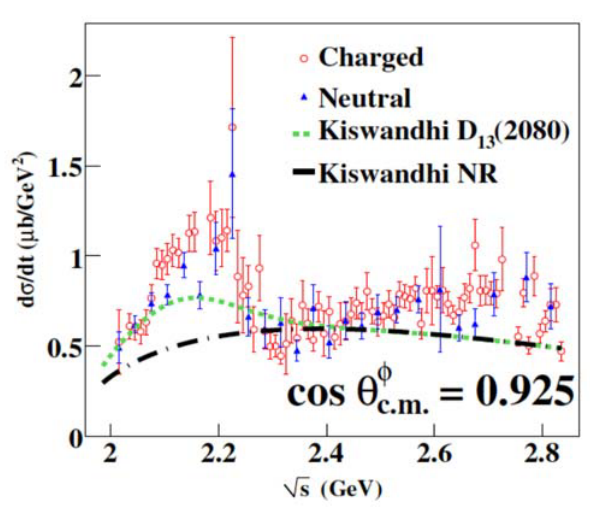
Fig. 11 Differential cross sections of γp → pφ production for the most forward angle bin. The two curves refer to fits without (dashed) and with (dotted) a known resonance at 2.08 GeV included.